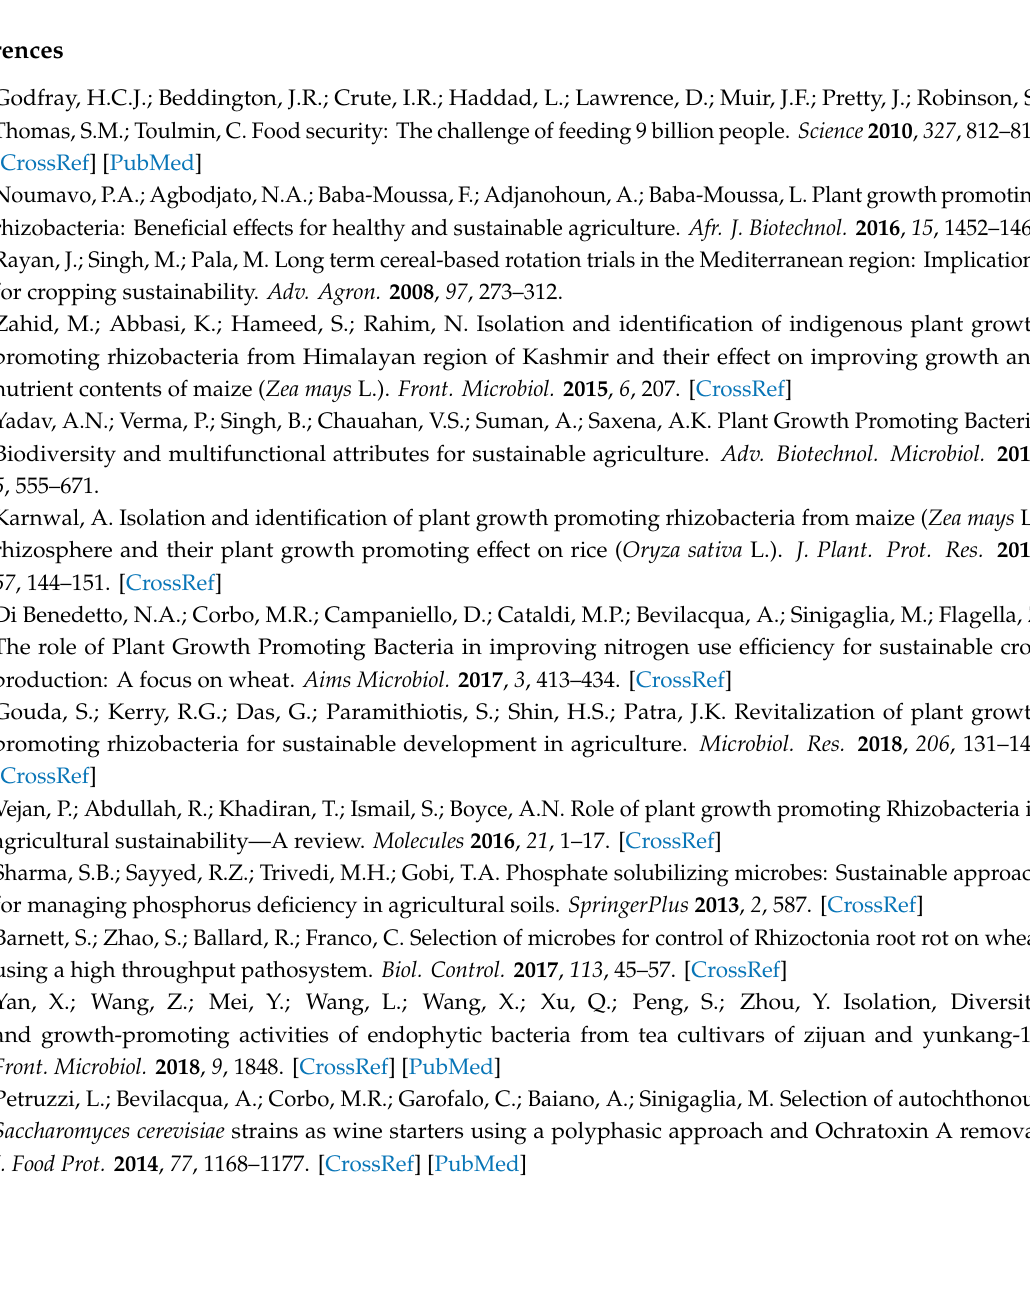
Table S2-A: One-way ANOVA (homogeneous group approach) on P-mineralization by mesophilic bacteria, S2-B: One-way ANOVA (homogeneous group approach) on P-mineralization by spore-forming bacteria, S2-C: One-way ANOVA (homogeneous group approach) on P-mineralization by pseudomonads, and S2-D: One-way ANOVA (homogeneous group approach) on P-mineralization by